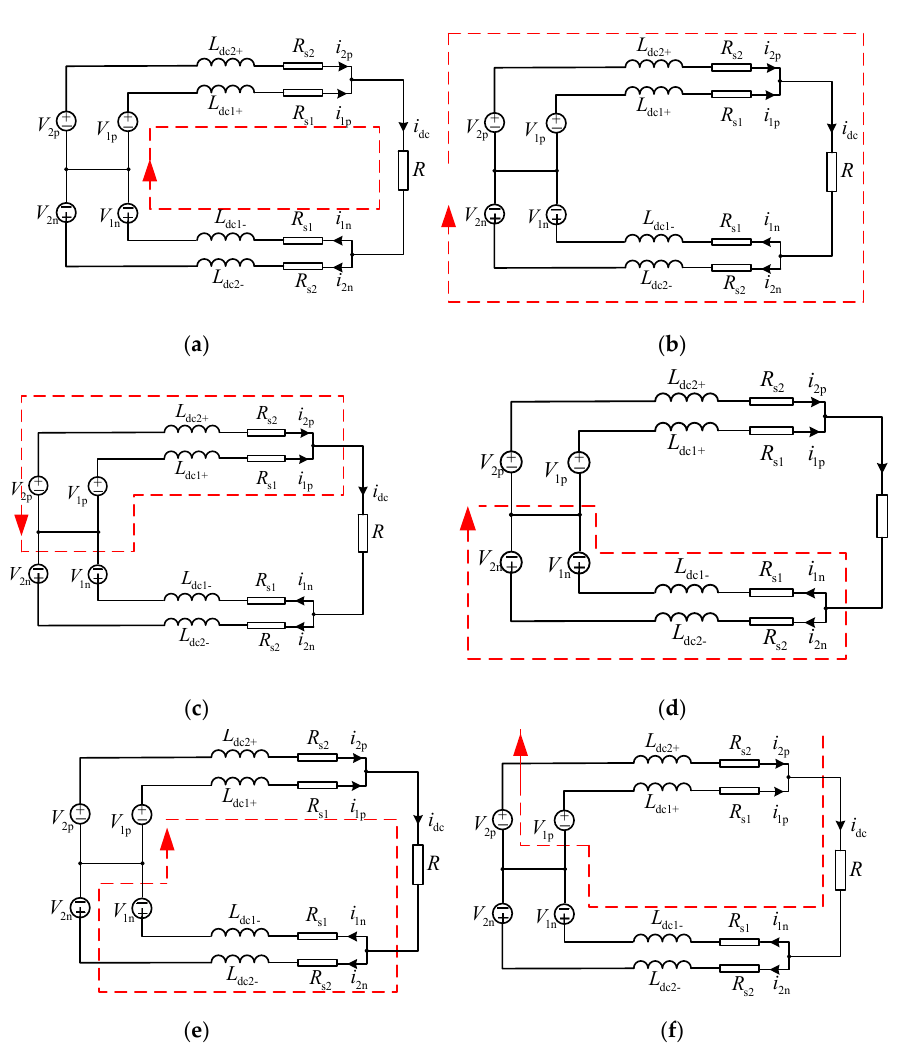
Figure 6c–f. The circulating current is the current that flows only between two parallel modules, and thus the four circulating current paths shown in Figure 6c–f are analyzed.